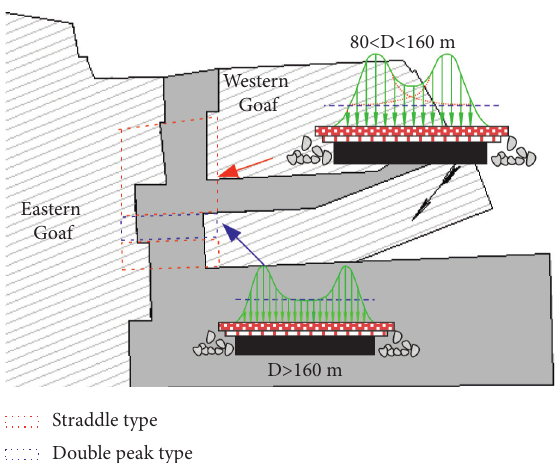
Figure 9: Schematic diagram of stress field distribution characteristics in the isolated coal pillar area.